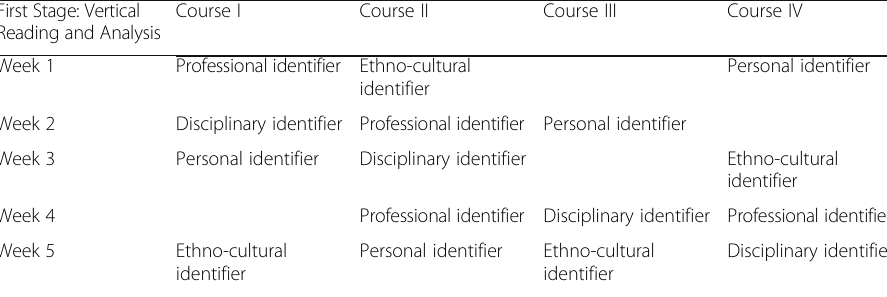
Table 1 First stage: vertical reading and analysis First Stage: Vertical Course Reading and Analysis